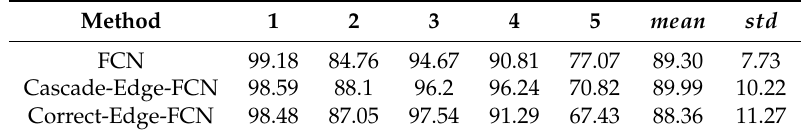
Table 8. Statistical validation on GID dataset. Here, “1–5” represents the accuracy of the corresponding category. “mean” and “std” reflect the statistical characteristics of category